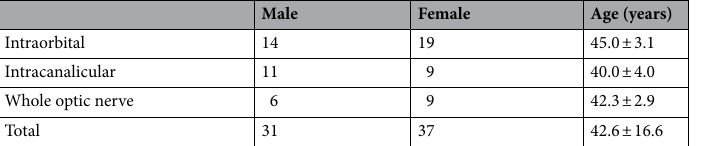
Table 1. Demographics. Gender did not differ between the three groups ( p = .596, Chi-square test). Age was also similar across the three groups ( p = .474, one-way ANOVA).